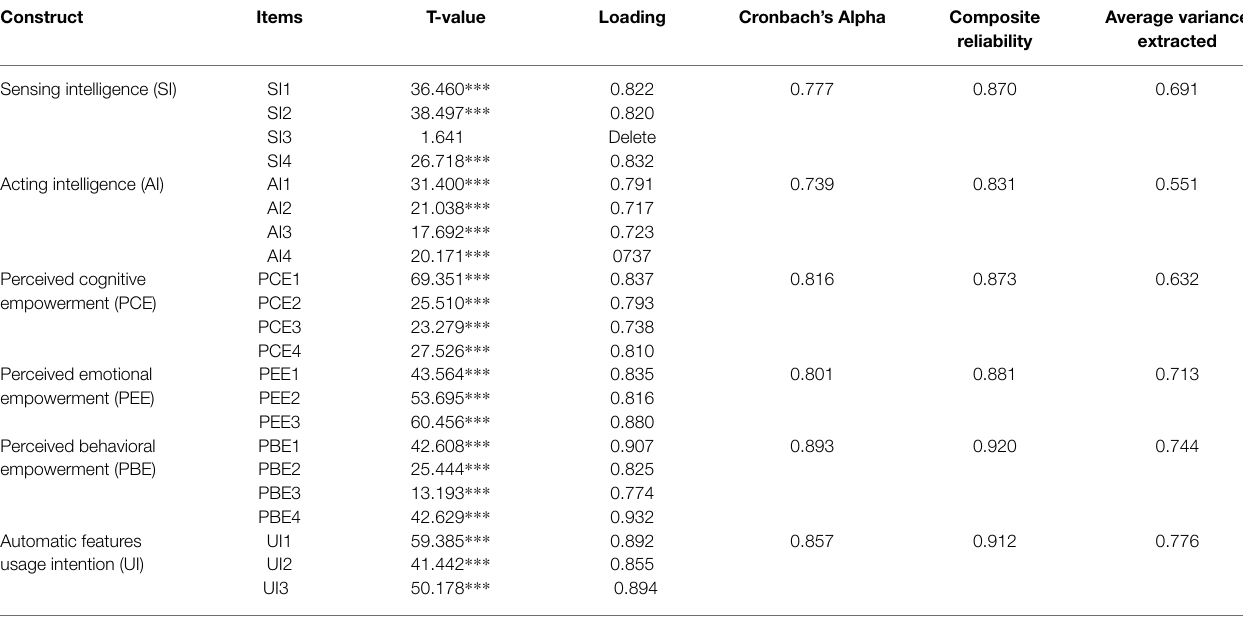
TABLE 3 | Results of confirmatory factor analysis. Construct